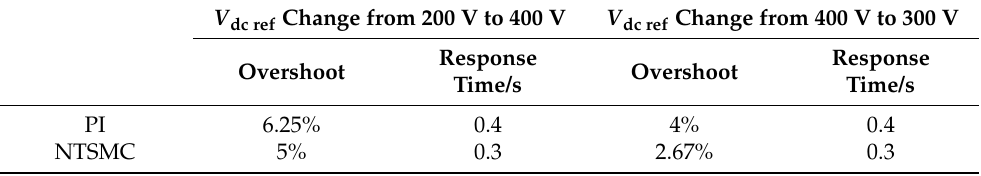
Table 1. Performance analysis and comparison of NTSMC and